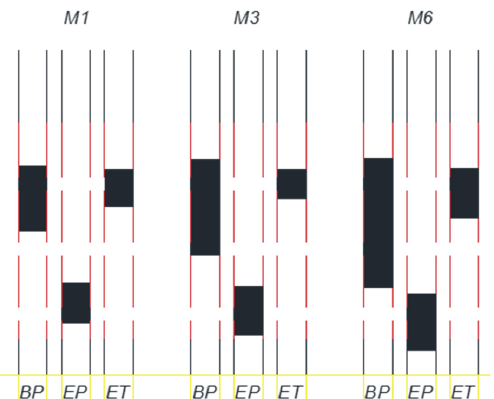
Figure 10. LNAPL thickness (Zo) in monitoring wells at the beginning of pumping (BP), end of pumping (EP), and end of test (ET) for E2.